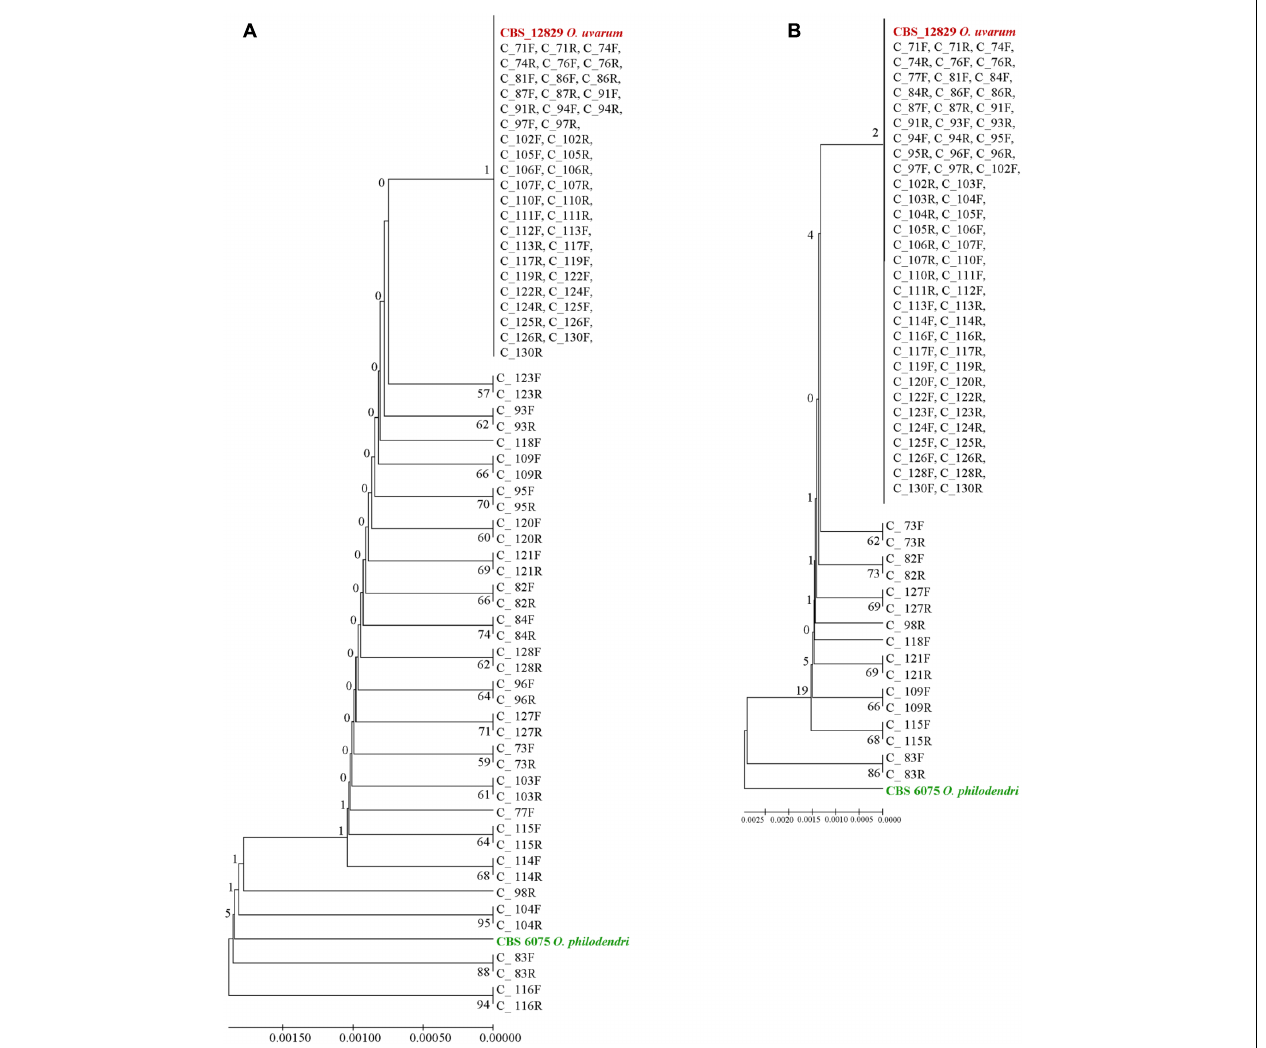
FIGURE 6 | UPGMA phylogenetic trees based on (A) concatenated ITS and LSU sequences and (B) ITS sequences alone. The evolutionary distances were computed using the Maximum Composite Likelihood method expressed as number of base substitutions per site. UPGMA trees were obtained using the Maximum Composite Likelihood with MEGA6; bootstrap support values were calculated with 100 replicates and are shown next to the branches. GenBank deposit numbers are reported in Supplementary Table S1